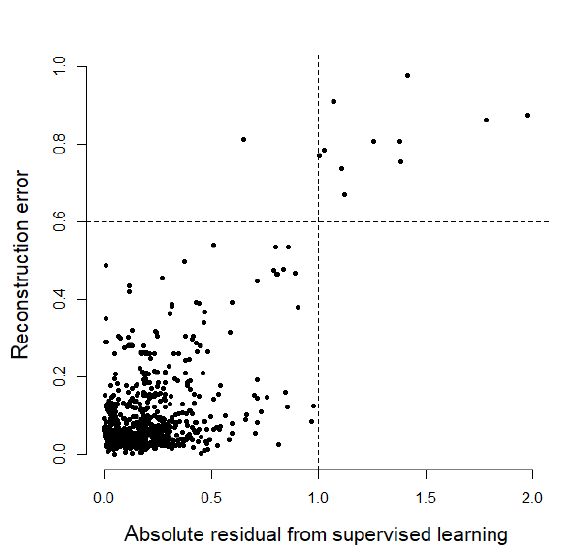
Figure 6. Convergence of the neural network